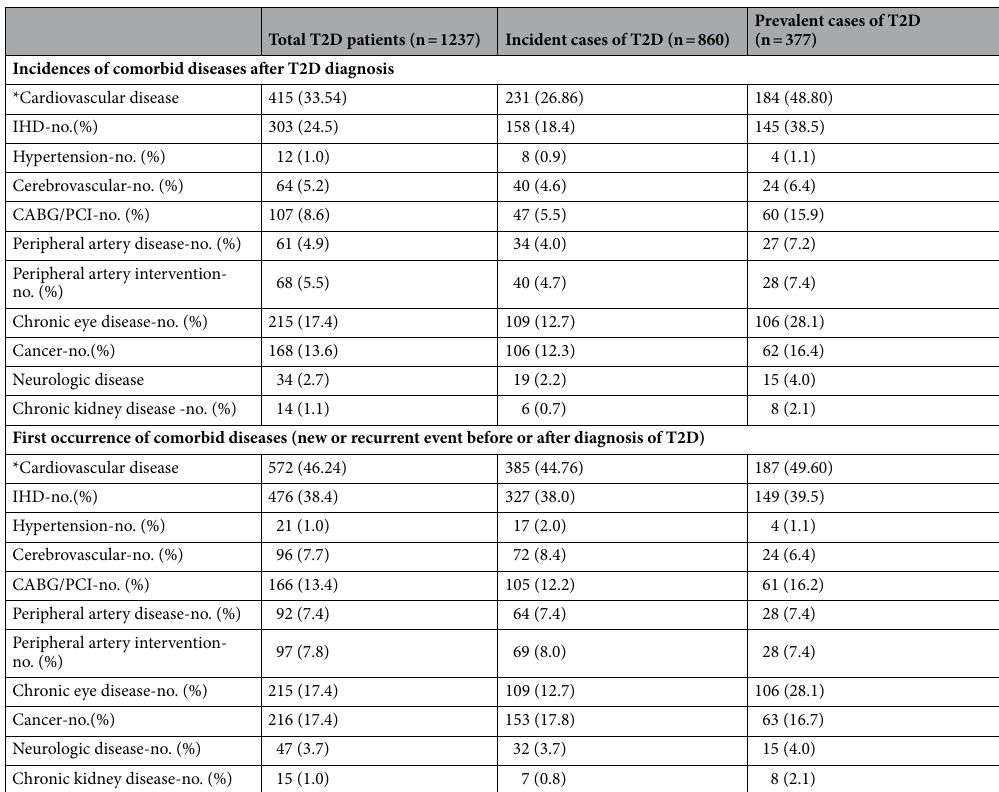
Table 2. Incidences of comorbid diseases in patient with T2D in UCP. We ascertained incident cases of a specified comorbid disease if a patient developed the comorbid disease after a diagnosis of T2D. *: Cardiovascular disease was diagnosed if a patient had at least one of these comorbid diseases. The number of CVD is less than the summary of this comorbid disease because some of the patients had more than one comorbid